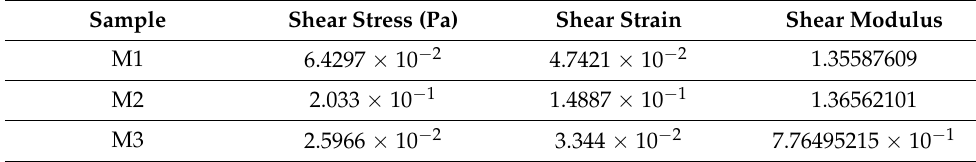
Table 3. The calculated shear stress and strain results from within the LVE range.